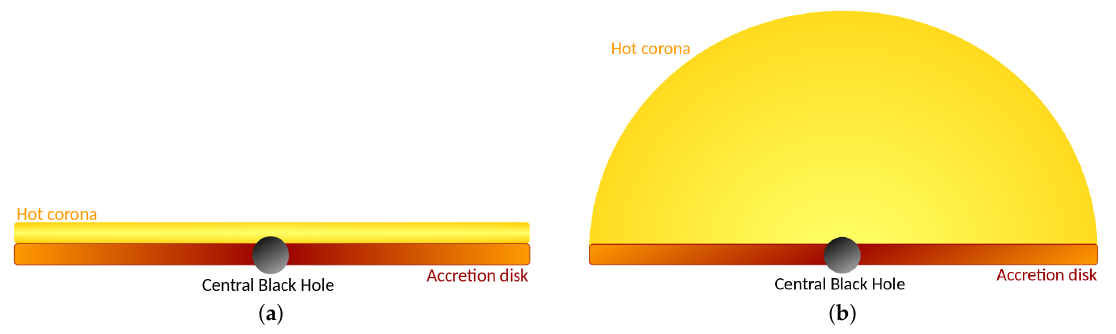
Figure 1. ( a ) Slab geometry for a hot corona distributed above an accretion disk surrounding the central black hole; ( b ) Spherical geometry for a hot